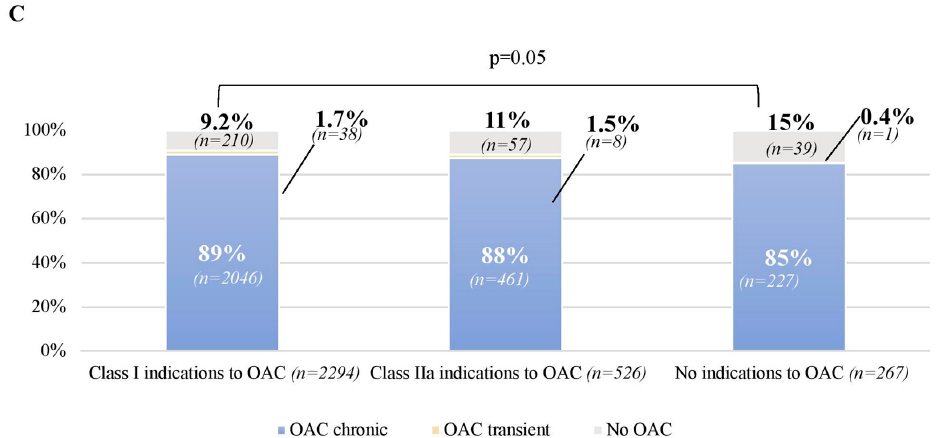
Figure 1. Oral anticoagulation in patients with atrial fibrillation/flutter undergoing transesophageal echocardiography before cardioversion or ablation. ( A ): Presence and type of oral anticoagulation ( n = 3107). ( B ): Dosing of non-vitamin K oral anticoagulants (NOAC) ( n = 2259). ( C ): Oral anticoagulation in relation to indications to chronic anticoagulation ( n = 3087). Legend: No indications to chronic anticoagulation: CHA 2 DS 2 -VASc 0 (if male) and 1 (if female). Class IIa indications to chronic anticoagulation: CHA 2 DS 2 -VASc 1 (if male) and 2 (if female). Class I indications to chronic anticoagulation: CHA 2 DS 2 -VASc ≥ 2 (if male) and ≥ 3 (if female) or moderate-severe mitral stenosis or mechanical valve prosthesis; Reduced doses for rivaroxaban, dabigatran and apixaban were 15 mg o.d., 110 mg b.i.d. and 2.5 mg b.i.d., respectively. Only one patient in the rivaroxaban group received a reduced dose of 10 mg o.d. Only p-values of 0.05 or lower were shown for group comparisons; Abbreviations: NOAC, non-voitamin K oral anticoagulant; OAC, oral anicoagulation; VKA, vitamin